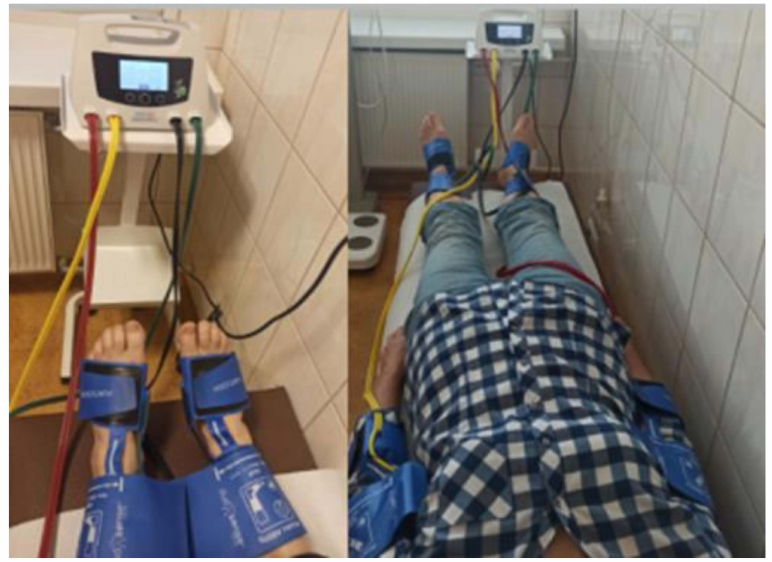
Figure 2. Volume plethysmography ABI measurement with use of the Dopplex ABIlity system, Huntleigh